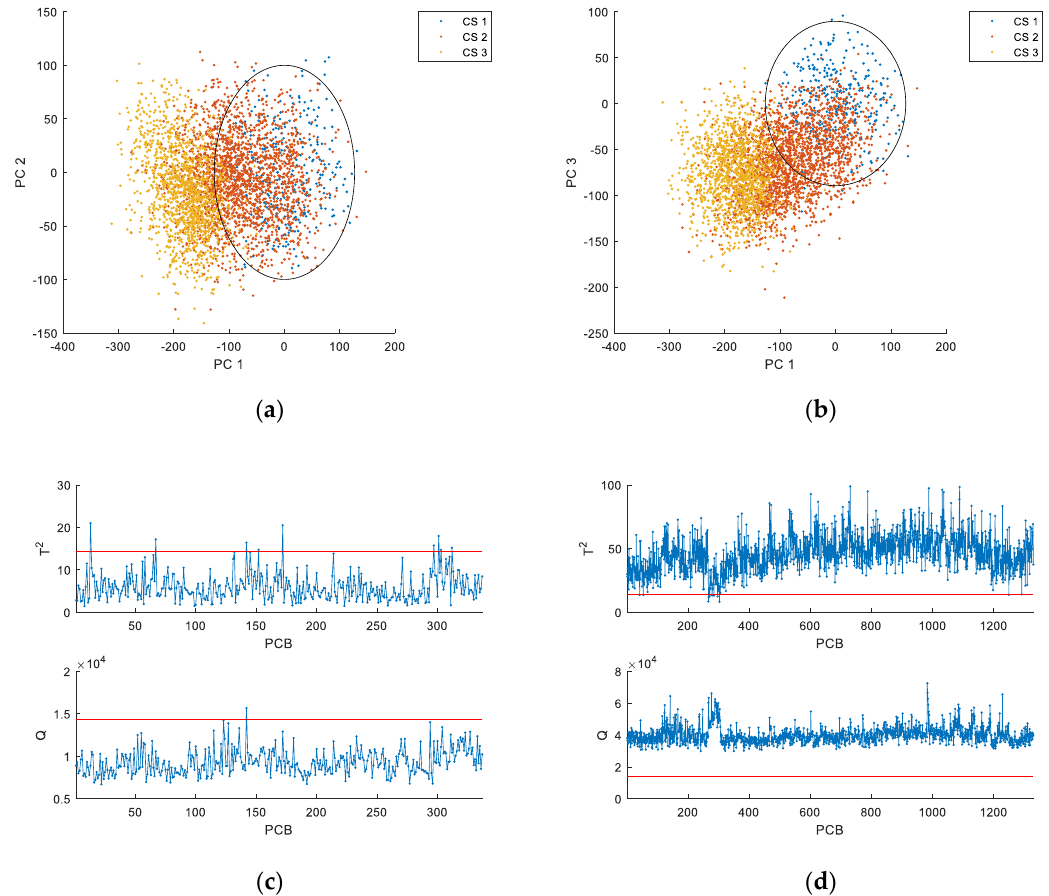
Figure 1. Projection of data from several production periods (designated as CS1, CS2 and CS3) on the principal components space estimated using CS1 as the reference dataset: ( a ) Scores plot of PC1 vs. PC2; ( b ) Scores plot of PC1 vs. PC3. The 99% confidence ellipses for the scores of CS1 are also represented; ( c ) MSPM-PCA monitoring statistics (Hotelling’s T 2 of the scores and the Q or SPE statistic of the residuals; see Section 4) for CS1, using CS1 as the reference dataset; ( d ) MSPM-PCA monitoring statistics for CS3, using CS1 as the reference dataset.